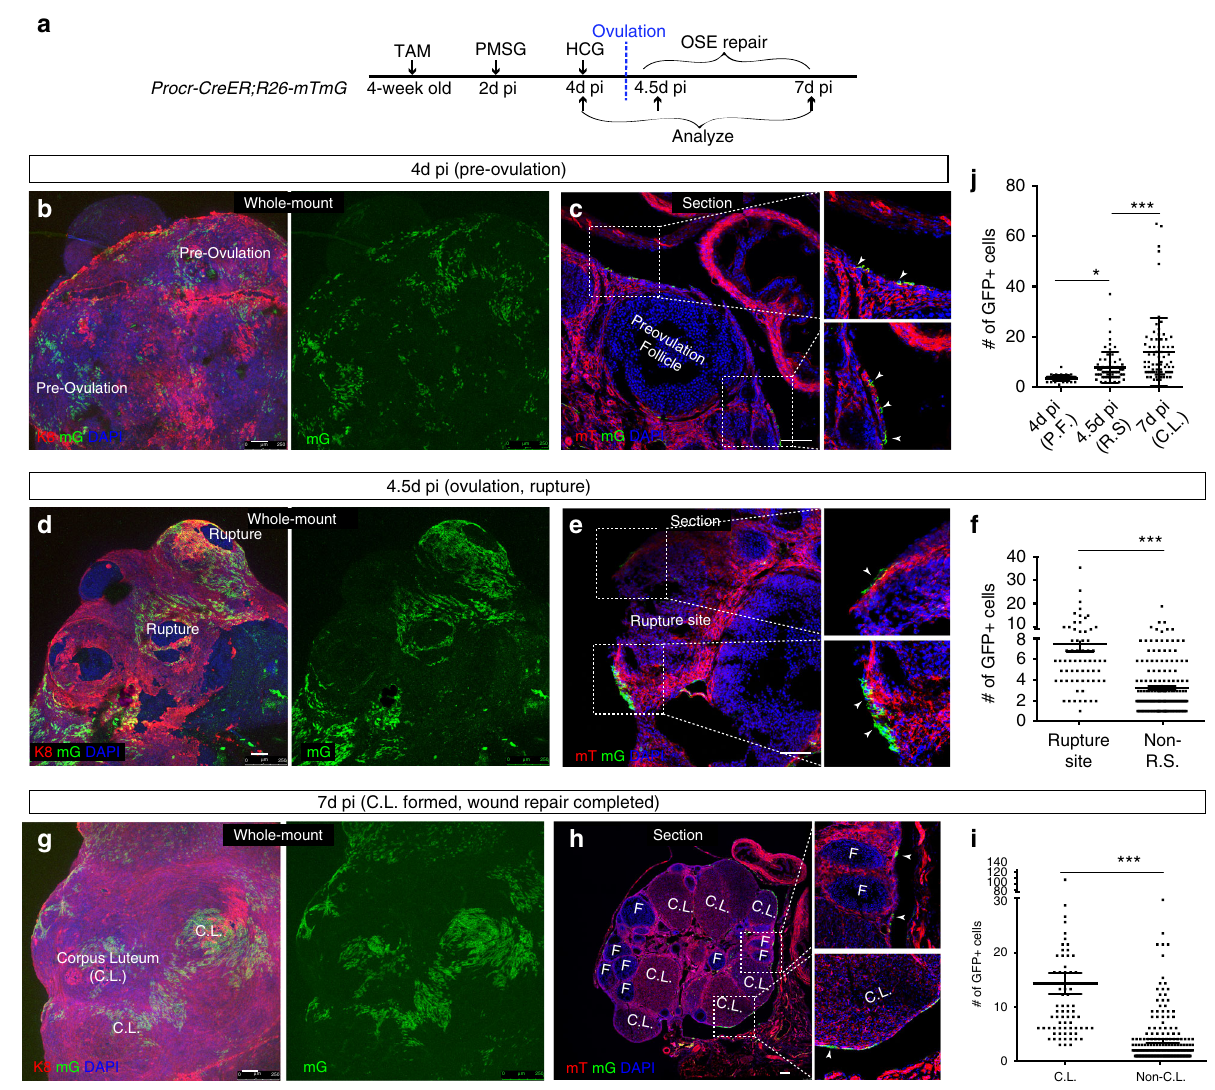
Fig. 2 Procr + cells contribute to OSE repair after ovulation. a Illustration of lineage tracing and superovulation-inducing strategy using Procr-CreER;Rosa26- mTmG mice. b , c At 4pi (pre-ovulation stage), ovary whole-mount confocal imaging showing dispersed GFP + cells in the OSE ( b ). n = 4 mice and eight ovaries images. Section imaging con fi rming the appearance of a few GFP + OSE cells on both sides of the pre-ovulation follicle ( c ). Scale bars, 100 μ m. n = 4 mice and 16 images. d – f At 4.5pi (ovulation stage), ovary whole-mount confocal image demonstrating zones of concentrated GFP + cells surrounding the rupture site (R.S.) ( d ). Section imaging con fi rming the appearance of abundant GFP + OSE cells at both edges of the rupture site ( e ). Scale bars, 100 μ m. Quanti fi cation of GFP + cell numbers (per 0.04 mm 2 area boxed by the dashed line) showing that GFP + cells by rupture sites are signi fi cantly more than those in randomly selected non-R.S. ( f ). n = 4 mice, > 40 areas were counted in each group. Unpaired two-tailed t test is used for comparison. *** P < 0.001. g – i At 7pi (repair completed stage), ovary whole-mount confocal imaging showing large GFP + patches located at corpus luteum (C.L.) area that can be distinguished by the residual protrusion ( g ). Section imaging demonstrating large patch of GFP + cells in the OSE covering corpus luteum (C.L.), whereas GFP + cells are fewer in areas where the OSE covers the follicle (F) ( h ). Scale bars, 100 μ m. Quanti fi cation of GFP + cells (per 0.04 mm 2 area) showing that GFP + cells in the C.L. area are signi fi cantly more than those in randomly selected non-C.L. sites ( i ). n = 4 mice, > 40 areas were counted in each group. Unpaired two-tailed t test is used for comparison. *** P < 0.001. j Quanti fi cation of GFP + cell numbers showing the continuous expansion of GFP + cells during tracing. At 4d pi, GFP + cells in the pre-ovulation follicle (P.F.) area were counted. At 4.5d pi, GFP + cells fl anking the rupture sites (R.S.) were counted. At 7d pi, GFP + cells covering the C.L area were counted. Each view was 0.04 mm 2 in size. n = 4 mice, > 40 areas were counted for each time point. One-way ANOVA with Tukey test is used for comparison of multiple groups. * P < 0.05, *** P <